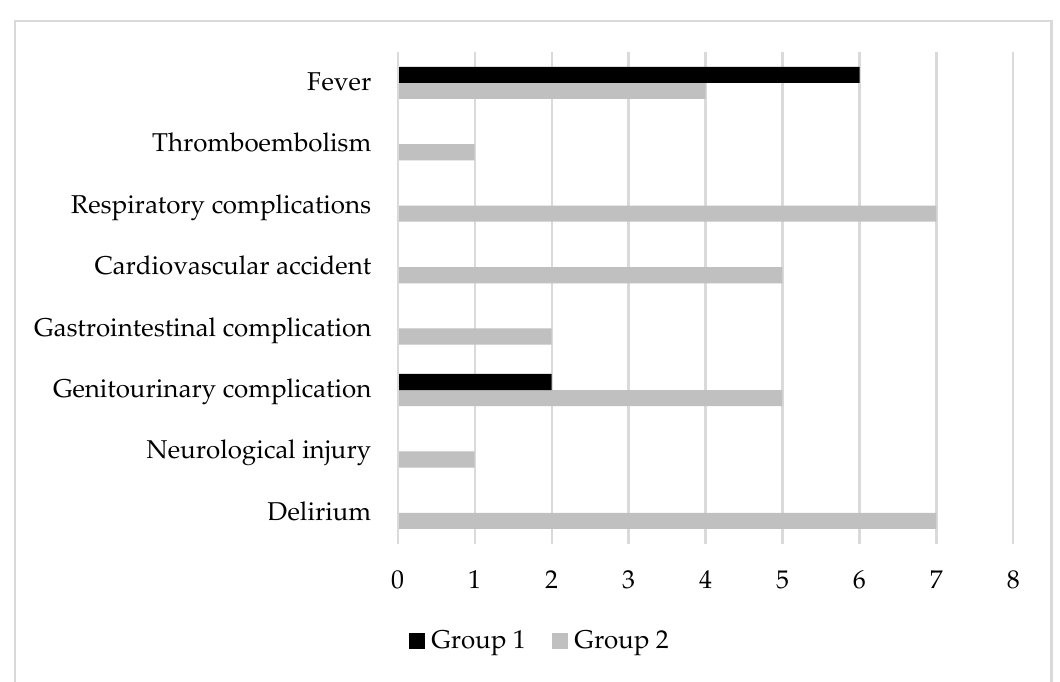
Figure 3. Perioperative systemic complications in the two groups. No significant differences in the two groups were observed for the hospital readmission rate at 30 days, 90 days, and 1 year (Figure 4). Readmission at 30 days occurred in 1 patient (1.4%) in Group 1 and 5 patients (6.7%) in Group 2 ( p 0.208); 90-day readmission occurred in 2 patients (2.7%) in Group 1 and 6 patients (8.0%) in Group 2 ( p 0.273); and 1-year readmission occurred in 8 patients (10.8%) in Group 1 and 7 patients (9.3%) in Group 2 ( p 0.784).